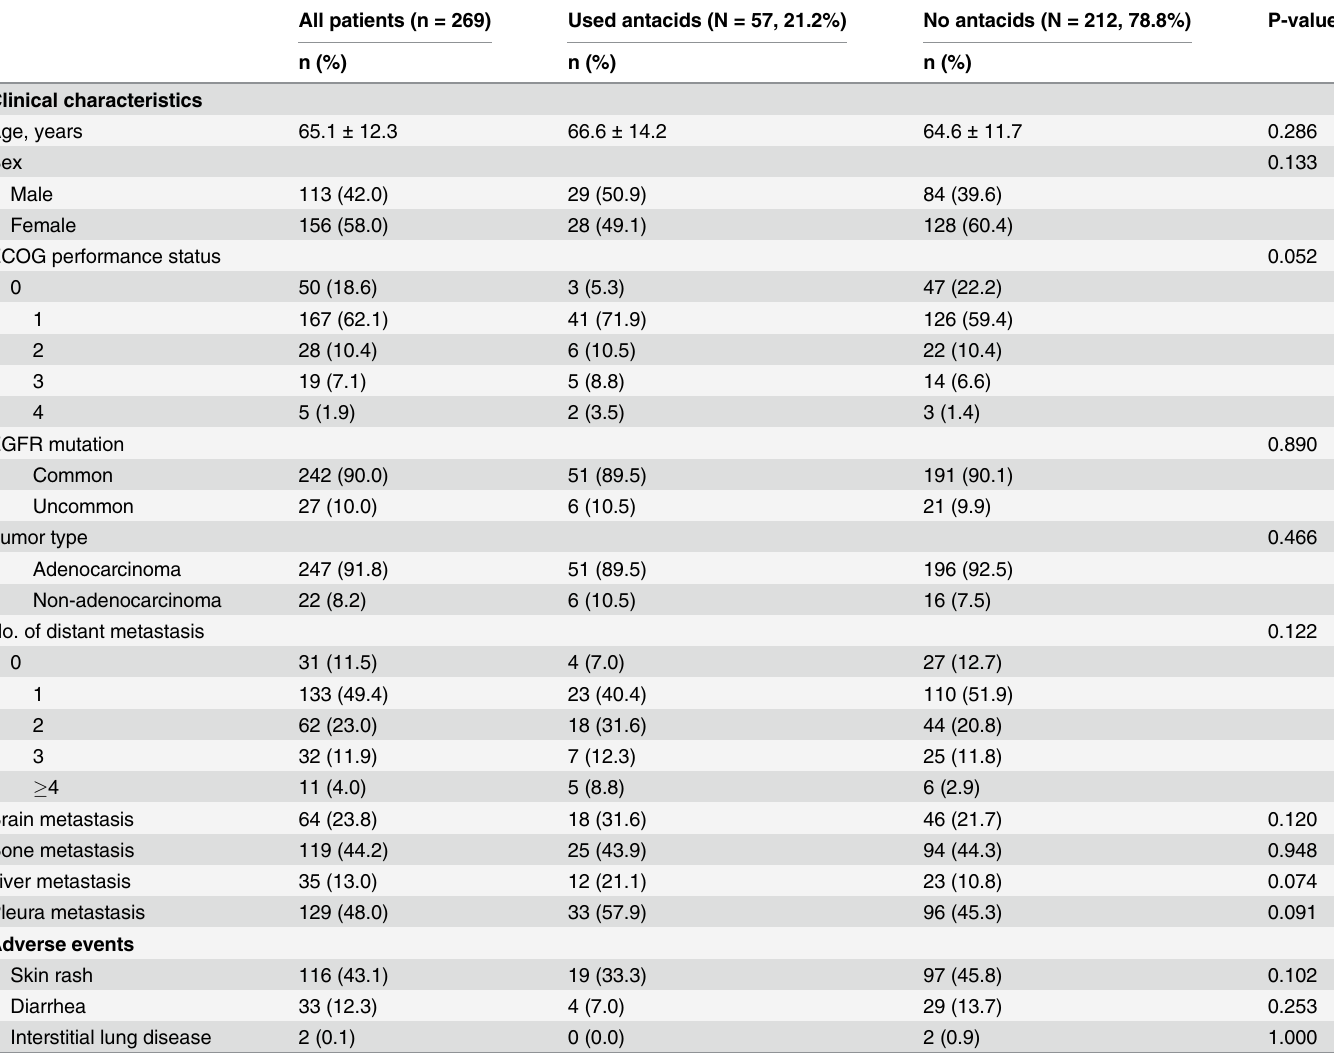
Table 1. The clinical characteristics of patients who did and did not use antacids. All patients (n = 269) Used antacids (N = 57,